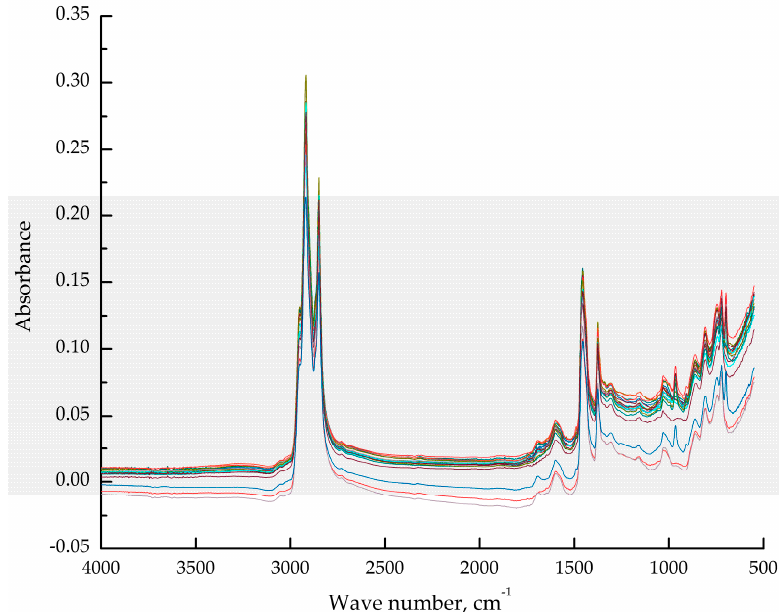
Figure 3. Attenuated total reflection Fourier infrared spectroscopy of 20 asphalt samples.